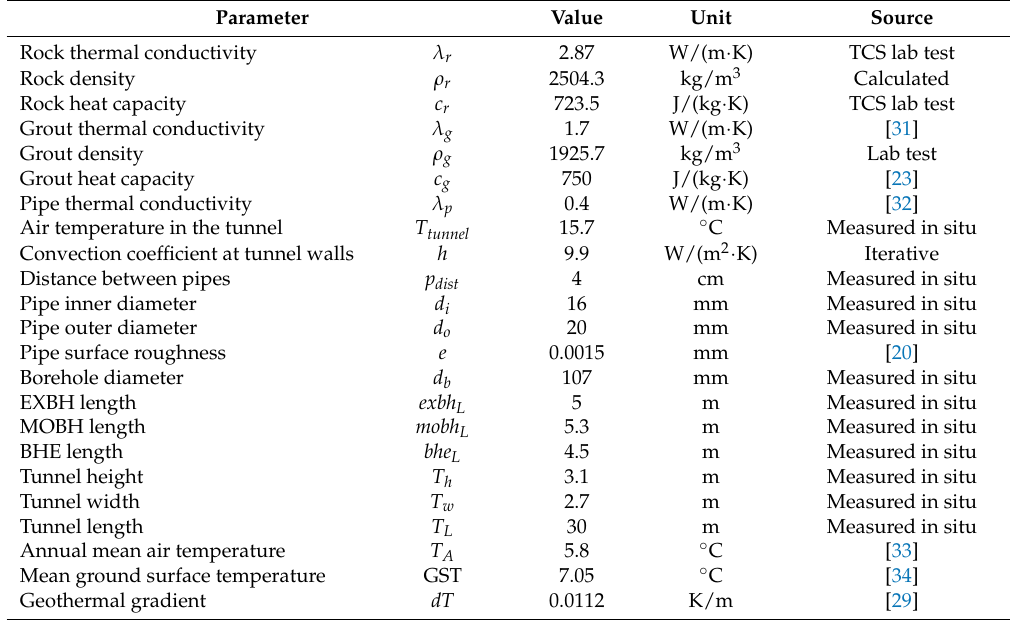
Table 1. Input parameters for the numerical models of the in situ